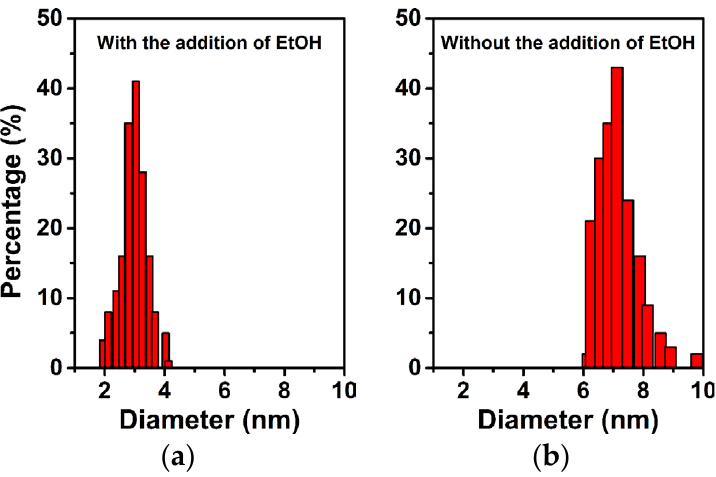
Figure 7. The size distribution of silicon species existing in the acid - leaching solution with ( a ) and without ( b ) the introduction of anhydrous ethanol .